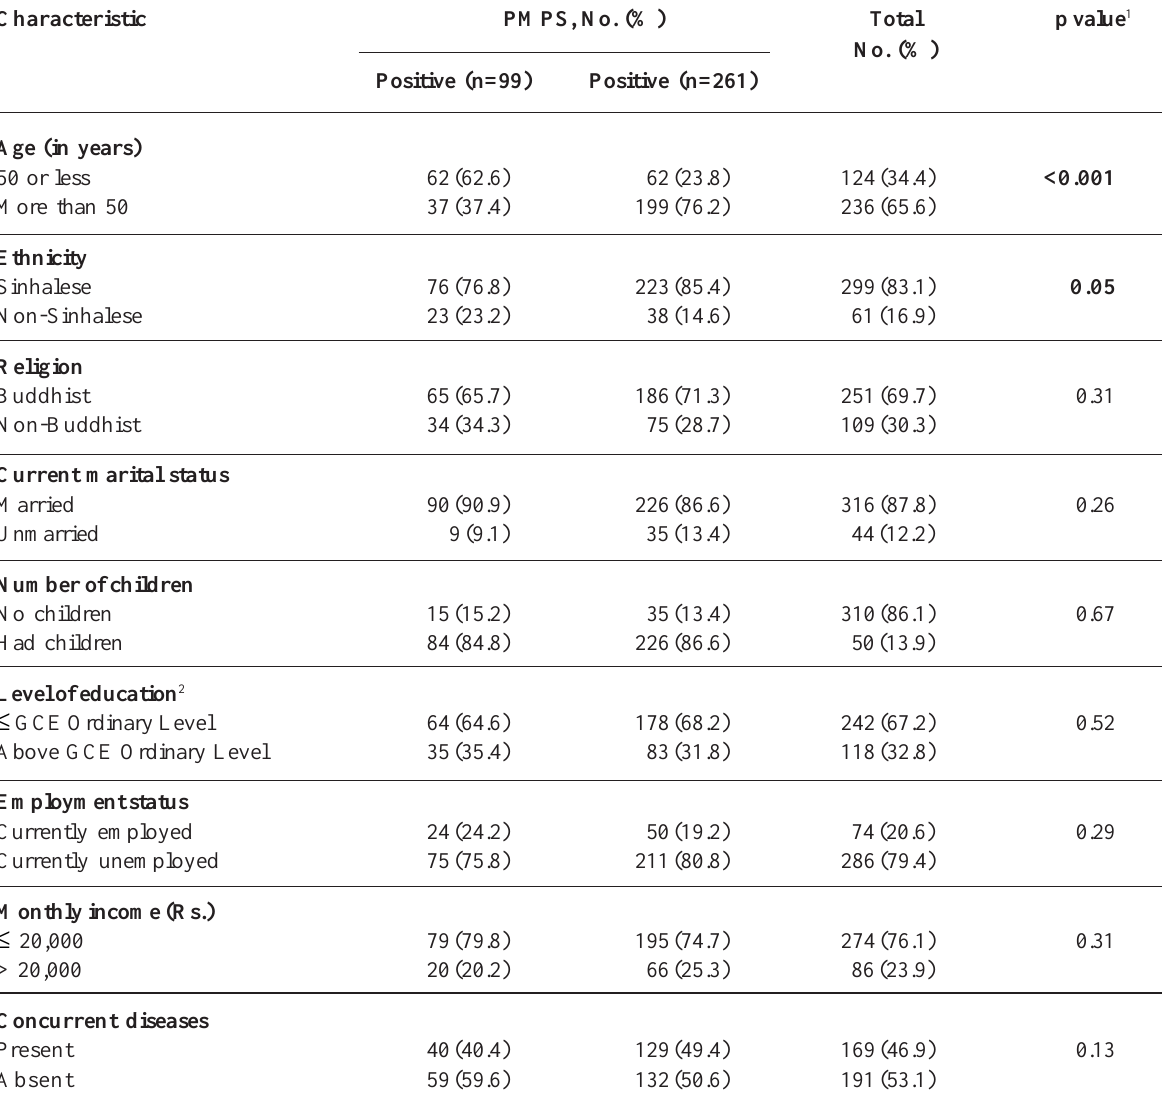
Table 2. Association of the social-demographic characteristics with PMPS (N=360) Characteristic PMPS, No.